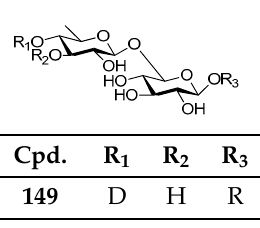
Figure 13. Structure of compound 148 .